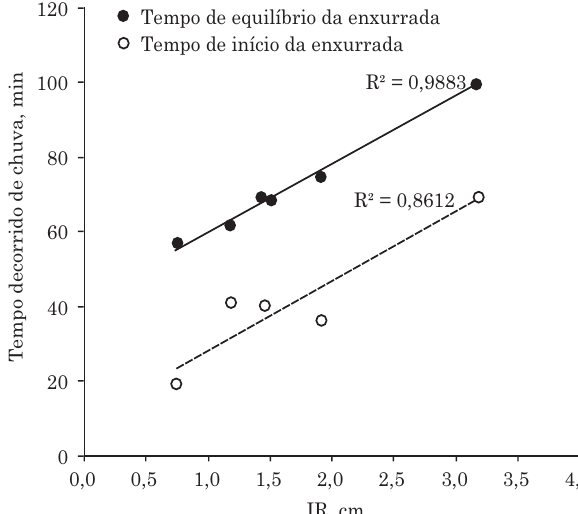
Figura 3. Relação dos tempos de início e equilíbrio da enxurrada medidos no primeiro teste de erosão (Teste 1), com chuva simulada, com o índice de rugosidade superficial do solo (IR) medido após o preparo do solo e a semeadura do